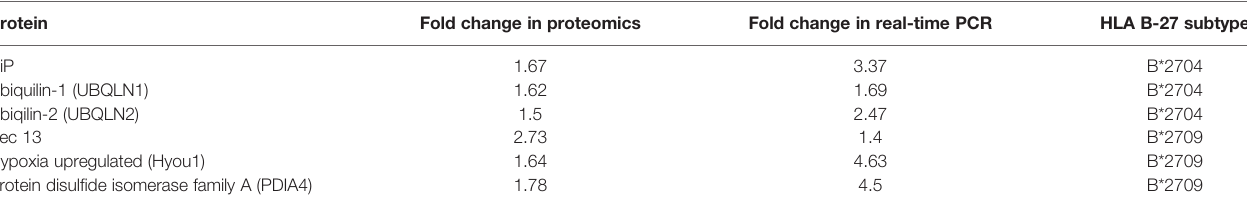
TABLE 4 | Comparison of fold change of protein expression for selected proteins, determined by proteomics-based evaluation as well as by real-time PCR analysis.